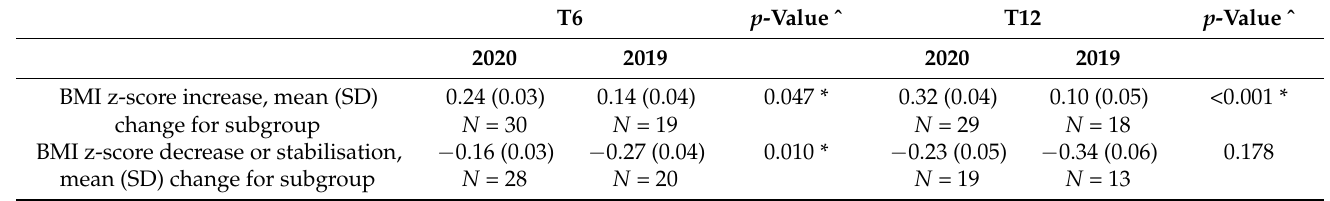
Table 2. Mean change for subgroups that had an increase or decrease/stabilisation in the BMI z-score at T6 and T12 in 2020, when compared to